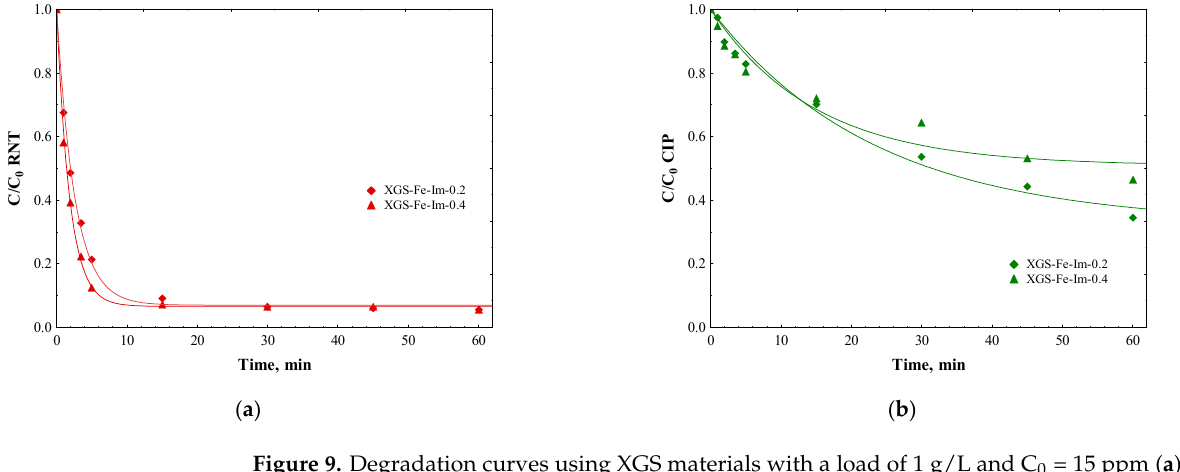
Figure 9. Degradation curves using XGS materials with a load of 1 g/L and C 0 = 15 ppm ( a ) RNT ( b ) CIP.